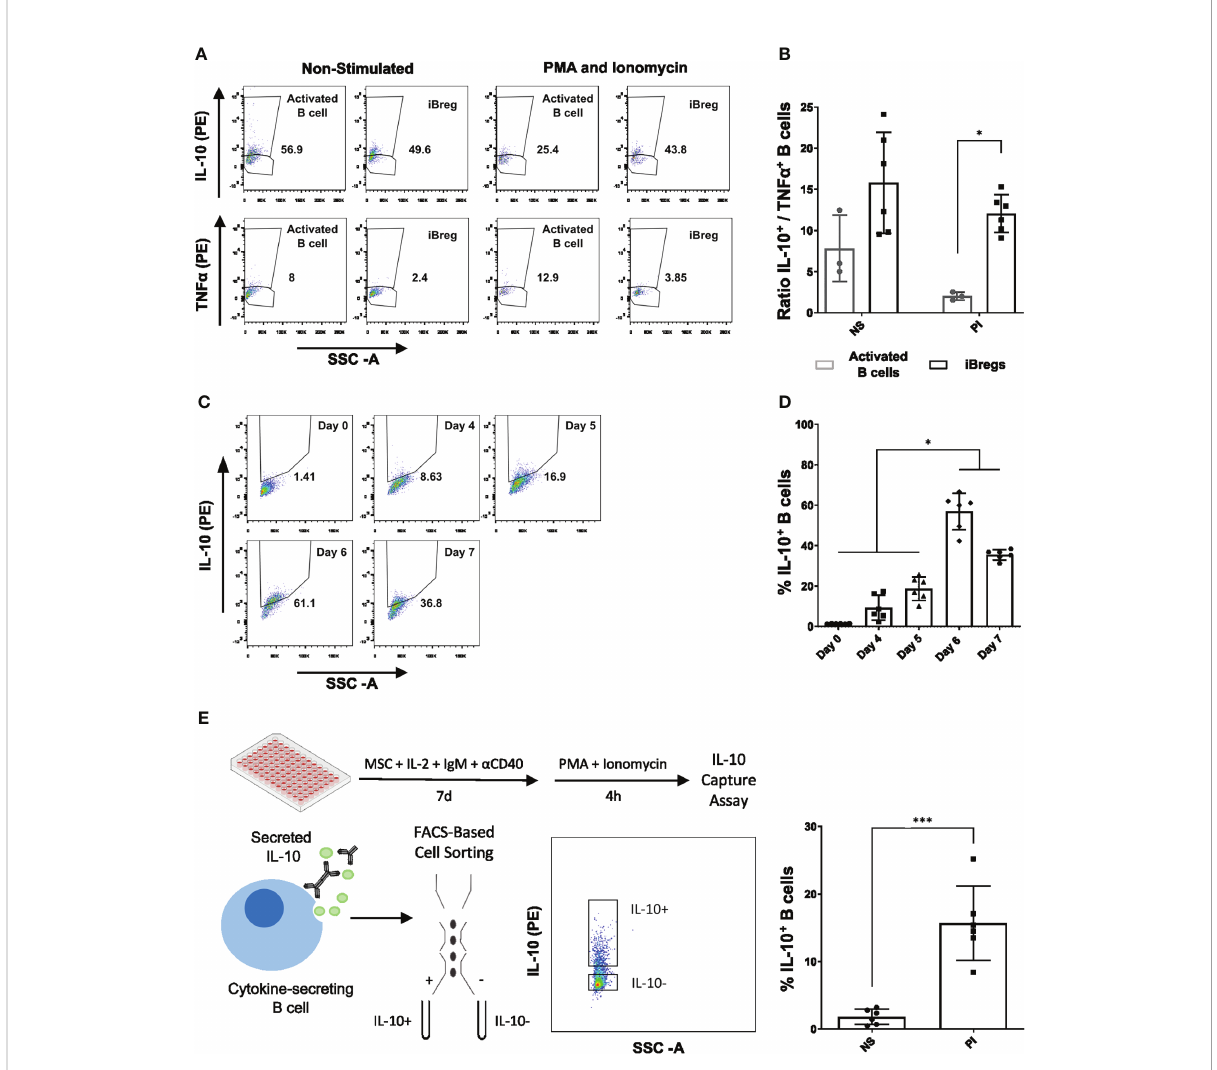
FIGURE 3 iBreg show high IL-10 + /TNF a + cell ratios after day 6 of culture, that remain constant after 4h PMA and Ionomycin stimuli. IL-10 capture assay was performed and used for downstream IL-10 + and IL-10 - fl ow cytometry associated cell sorting showing optimal results in PMA and Ionomycin samples. (A) Representative FACS plots showing the percentage of IL-10 and TNF a positive B cells in Activated B cell and iBreg conditions. (B) Ratio of IL-10 + and TNF a + B cells after 7-day culture by intracellular staining after 4h stimulation with PMA and Ionomycin (PI) or without further stimulation (NS). In PI samples only iBreg retain high ratio IL-10 + /TNF a + , showing higher phenotypical stability and regulatory cytokine pro fi le, which was comparable to NS iBreg allowing for the use of PI stimuli for downstream applications. (C) Representative FACS plots showing the percentage of IL-10 positive iBreg at days 0, 4, 5, 7 of culture (D) Analysis of the percentage of IL-10 + B cells over 7-day culture performing 4h PMA and Ionomycin stimulation and intracellular staining. iBreg show a signi fi cant increase of IL-10 + B cells after day 6, suggesting optimal IL-10 expression at day 6 and 7 (C) Graphical protocol for IL-10 capture assay and the associated FACS-based cell sorting of IL-10 + and IL-10 - populations (E) Percentage of IL-10 + cells by fl ow cytometry in sorted samples. A total of 6 samples were sorted in each condition. PI samples showed high percentages of IL-10 + cells that allowed for transcriptomic analysis. For fi gures A and B Data shows at least three independent experiments in each group. Cells from 2 MSC donors and 3 Tonsil donors were used. Figure D represents per condition 6 sorted samples, performed in three batches of 2 samples. Error bars represent SD. Two-way ANOVA, One-way ANOVA or non-parametric T- test was performed to determine statistical signi fi cance. *p < 0.05, ***p <